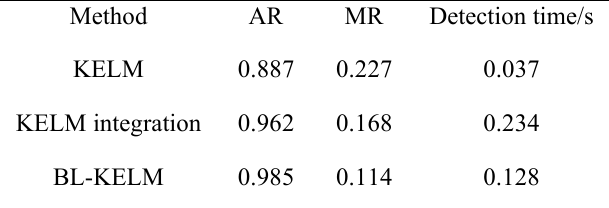
Table 1. Performance comparison